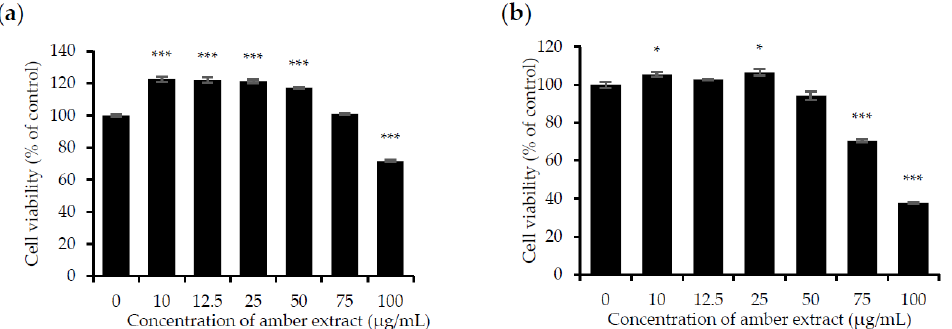
Figure 1. Effect of amber extract on cell viability: ( a ) Cell viability of RAW 264.7 cells. ( b ). Cell viability of RBL-2H3 cells. After culturing the cells with amber extract (0, 10, 12.5, 25, 50, 75, and 100 µ g/mL) for 24 h, cell viability was measured using the MTT assay (* p < 0.05, *** p < 0.001 vs. control).